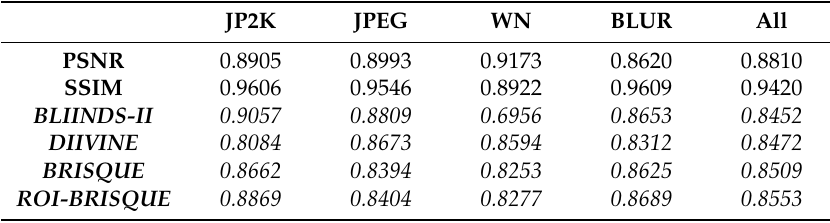
Table 8. SROCC results obtained by training on the LIVE IQA database and testing on the CSIQ database. Italicized algorithms are NR IQA algorithms, others are FR IQA